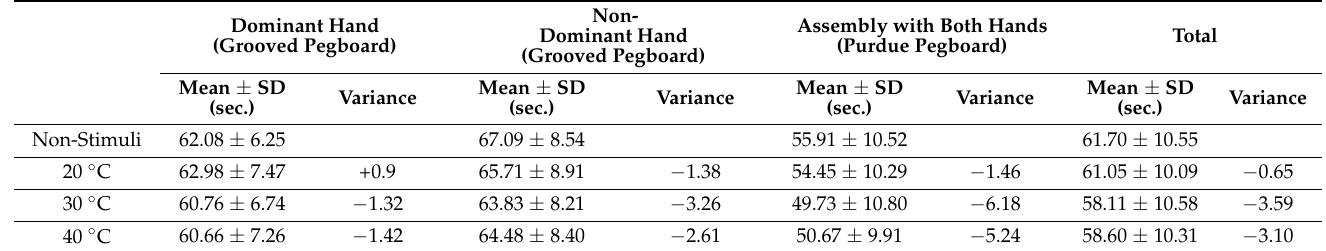
Table 1. Changes in hand dexterity according to the thermal stimuli.